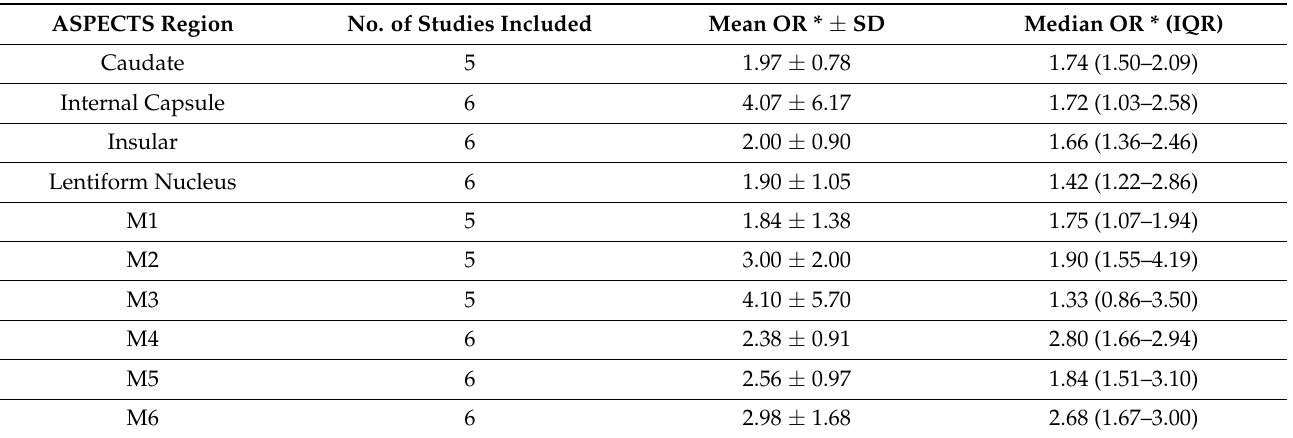
Table 4. Summary of mean and median of reported odds ratios for infarcts in 10 ASPECTS regions with functional outcomes at 90 days.